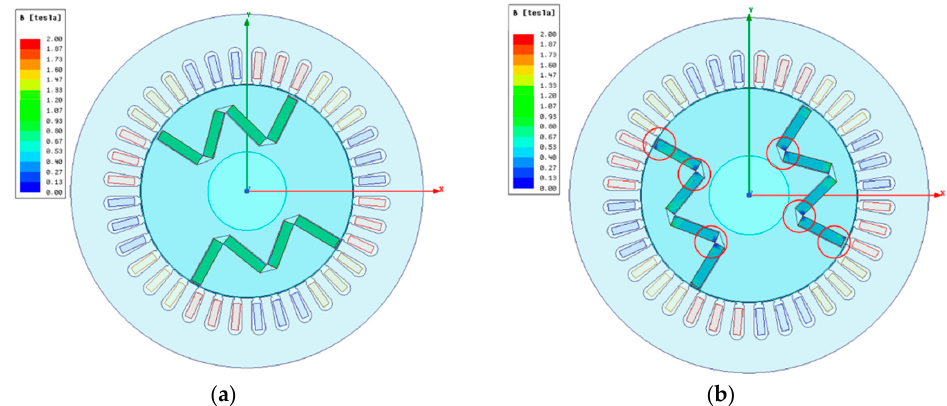
Figure 17. Open circuit–short circuit–open circuit test at 150 °C: ( a ) currents and ( b ) torque.